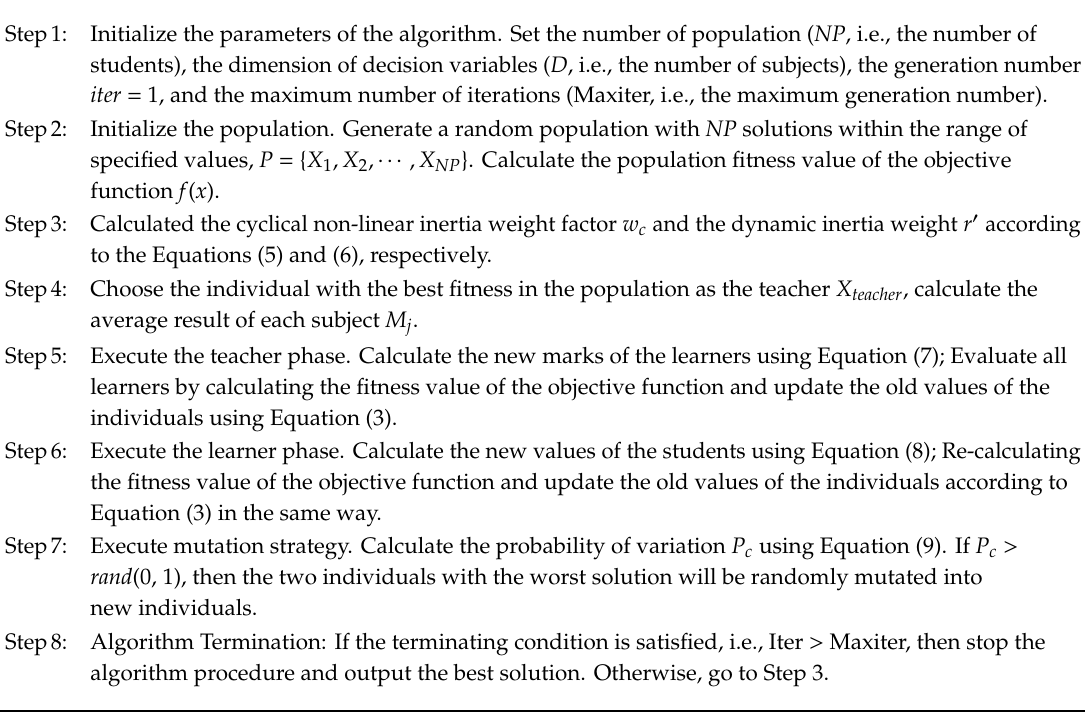
Algorithm 1 The Framework of